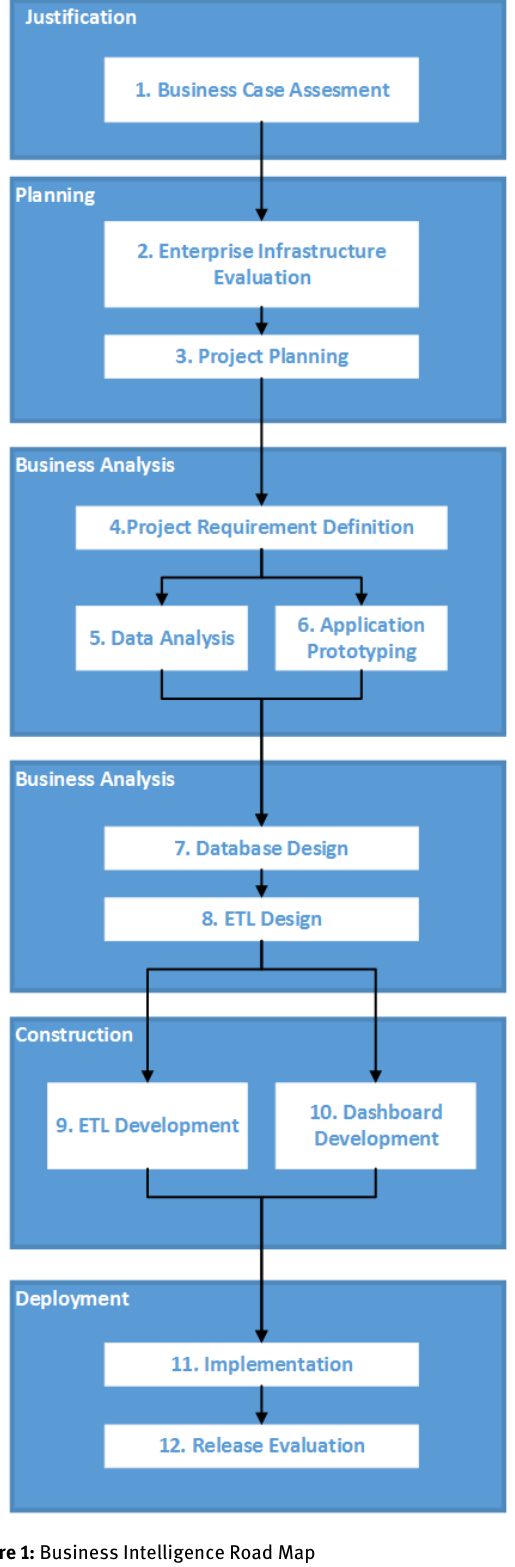
Figure 1: Business Intelligence Road